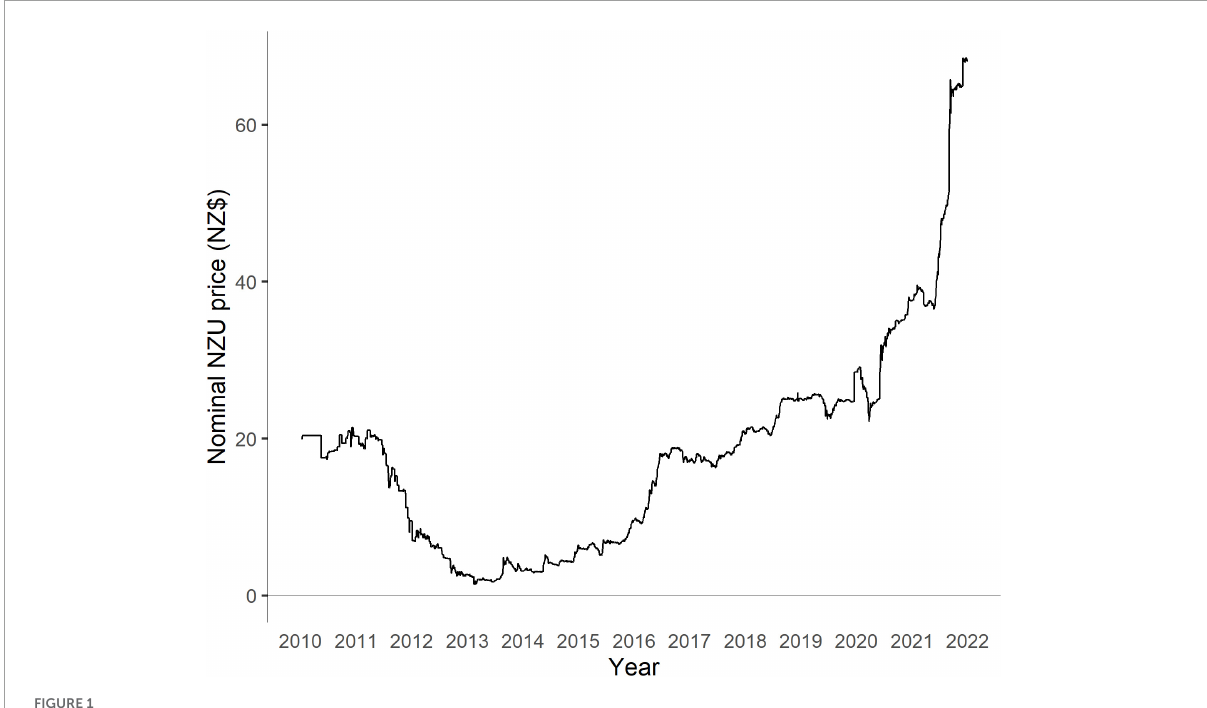
FIGURE1 Evolution of NZU prices, 2009–2021. Data from Jarden (2022); used with